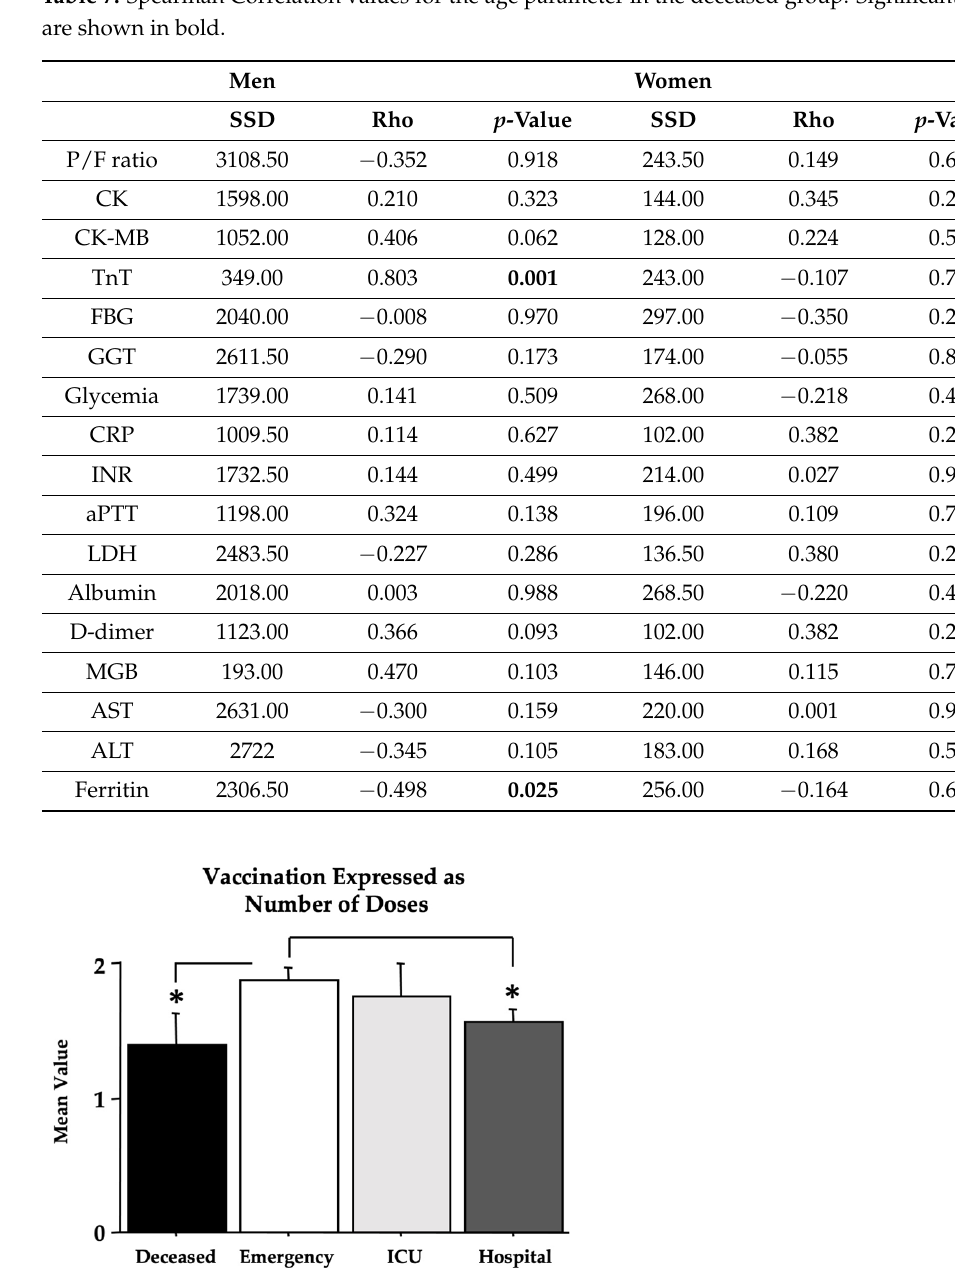
Figure 9. Vaccination effects on LDH and TnT (see Section 3). The error bars indicate pooled stand ‐ ard error means (SEM) derived from the appropriate error mean square in the ANOVA. The aster ‐ isks (* p < 0.05) indicate post hoc differences between groups.